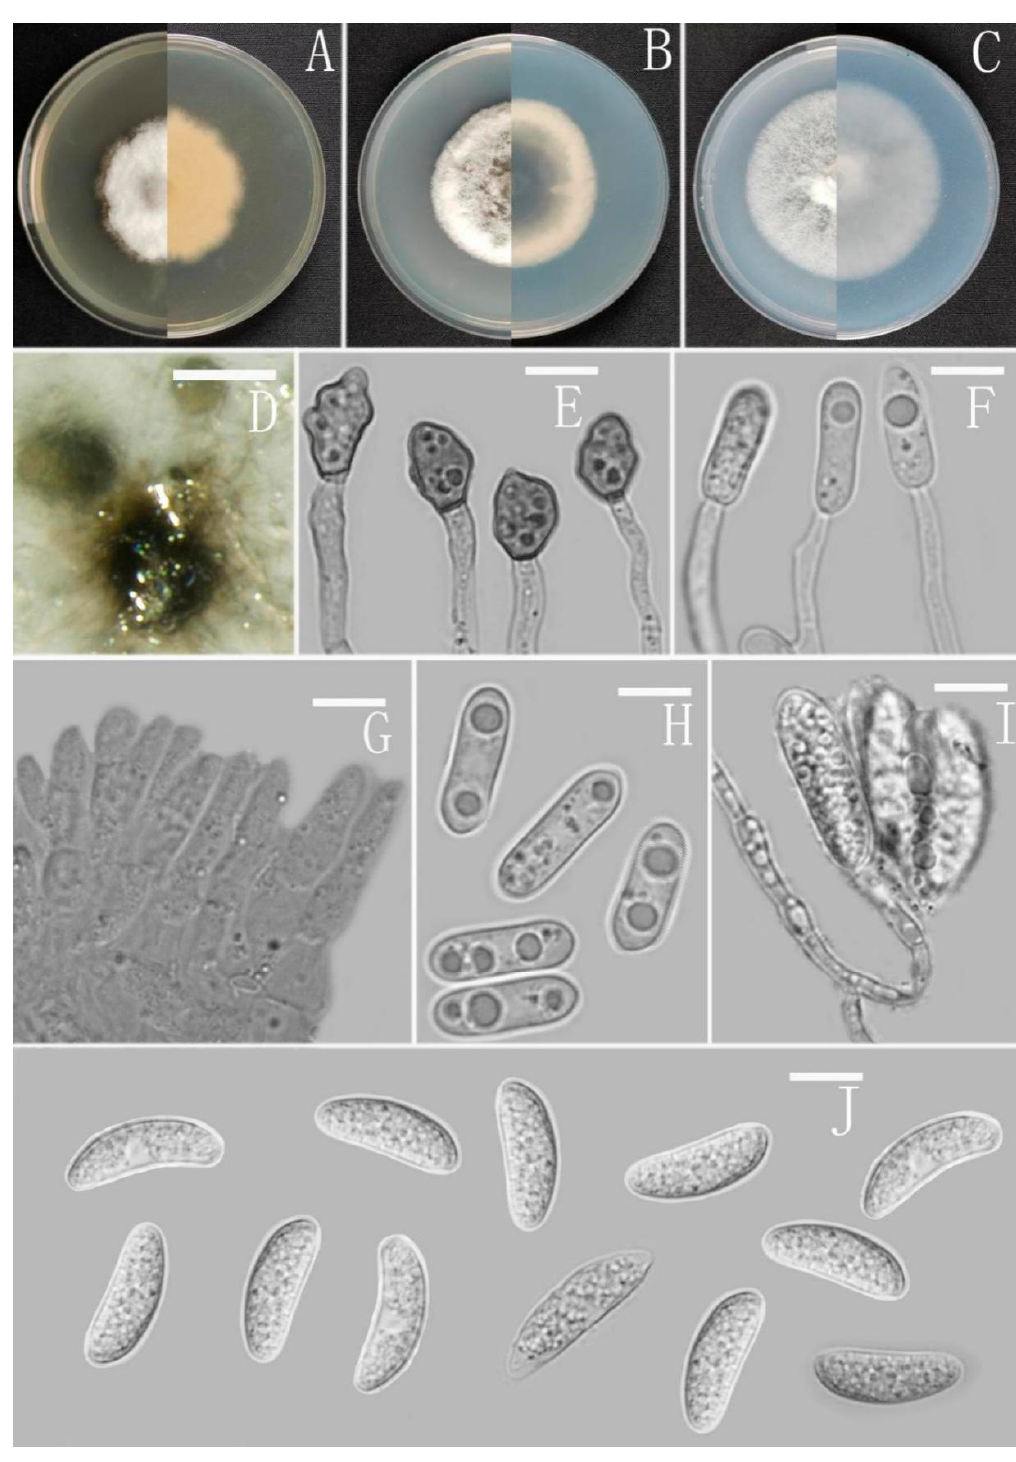
Figure 8. Colletotrichum nullisetosum (YMF1.06946). ( A – C ) Colonies on media above and below after 7 days at 25 °C (( A ) MEA; ( B ) PDA; ( C ) SNA). ( D ) Conidiomata. ( E ) Appressoria. ( F ), ( I ) Conidiophores. ( G ) Conidiophores and Conidia. ( H ), ( J ) Conidia. Scale bars: ( D ) = 100 μ m, ( E – J ) = 10 μ m. Sexual morph not observed. Asexual morph on CMA. Conidiomata rudimentary, dark olivaceous brown. Setae not observed. Conidiophores directly formed on hyphae, hyaline, smooth-walled, unbranched. Conidiogenous cells hyaline, cylindrical to clavate, smooth- walled, collarette absent. Conidia unicellular, hyaline, dimorphic; (i) straight